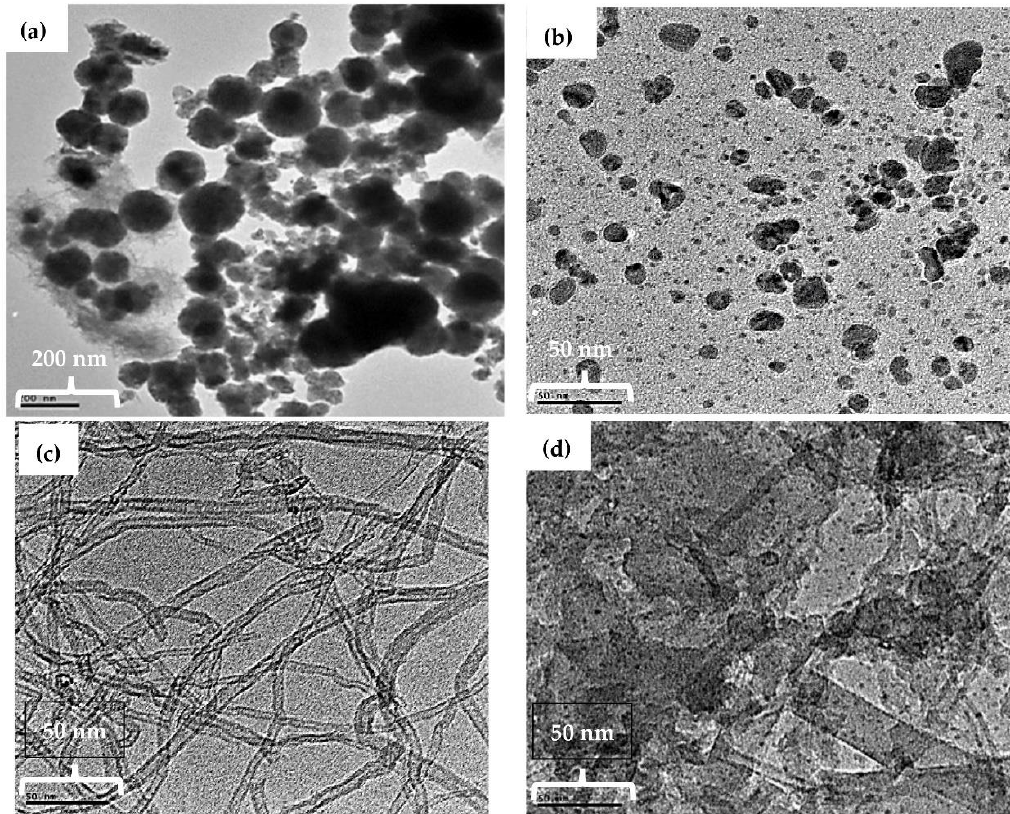
Figure 5. TEM images of ( a ) NiNp, ( b ) Pc, ( c ) fMWCNTs, and ( d ) NiPcMWCNTs nanocomposite with the size of scale bar: Ni (200 nm), Pc (50 nm), fMWCNTs (50 nm), and NiPcMWCNTs (50 nm).